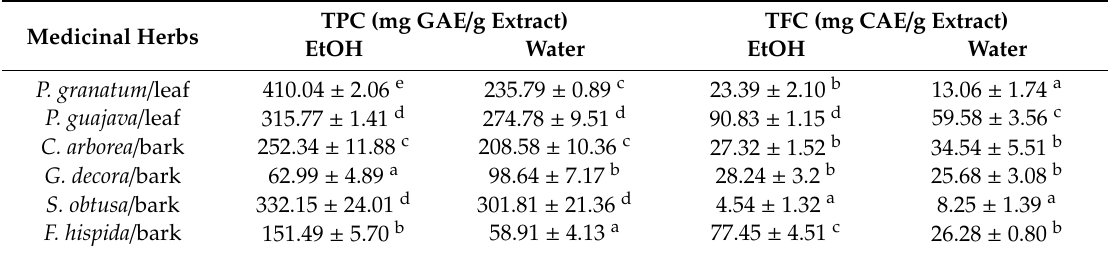
Table 2. Total phenolic and flavonoid compounds contained in the EtOH and water